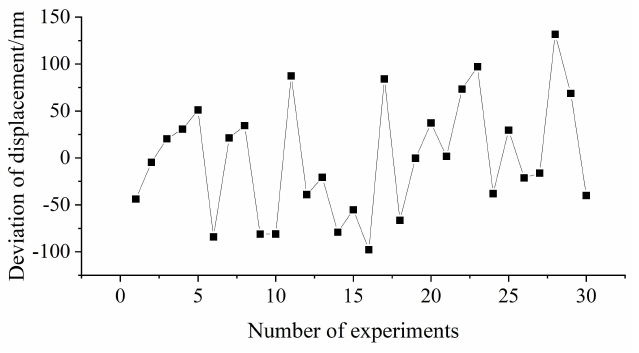
Figure 22. Displacement measurement experiment results.